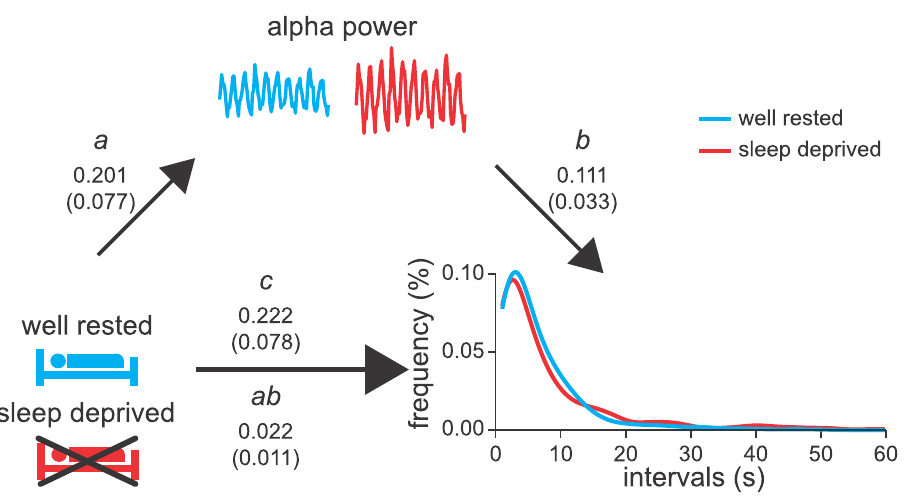
Figure 6. Alpha power partly mediates sleep deprivation-induced increased perceptual duration of perceptual representations. The estimated values are given for each path, with the s.e. shown in brackets. Sleep deprivation increased the duration of individual perceptual representations (path c ). In particular, after sleep deprivation, the stability of individual perceptual representations was less likely to last less than 10 s and more likely to last around 20 s. In agreement with previous work, sleep deprivation increased eyes-open alpha power (path a ). Mediation analysis suggested this increase in alpha power contribute to the increase in the duration of individual perceptual representations (path ab